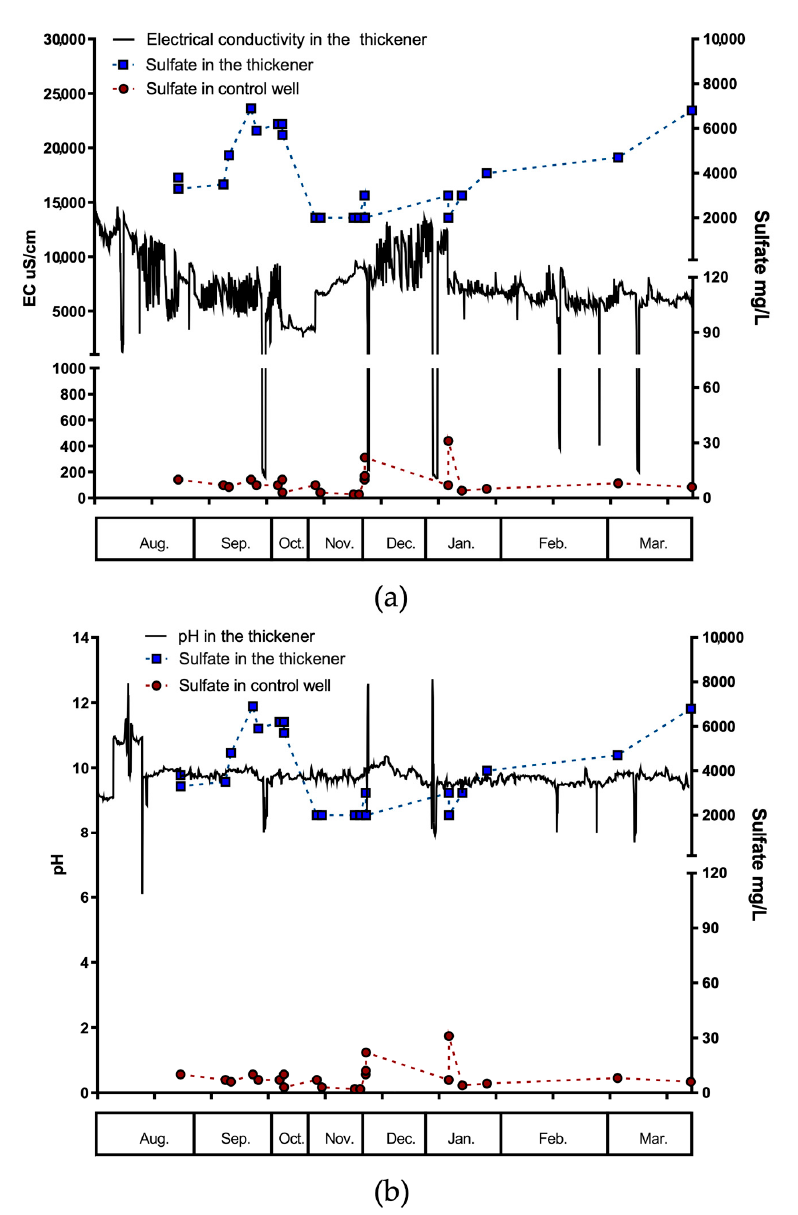
Figure 7. Analysis of the time series of real-time electrical conductivity ( a ) and pH ( b ) of the thick- ener and the relationship with the sulfate concentrations of the thickener and the control well. The time-series data were measured